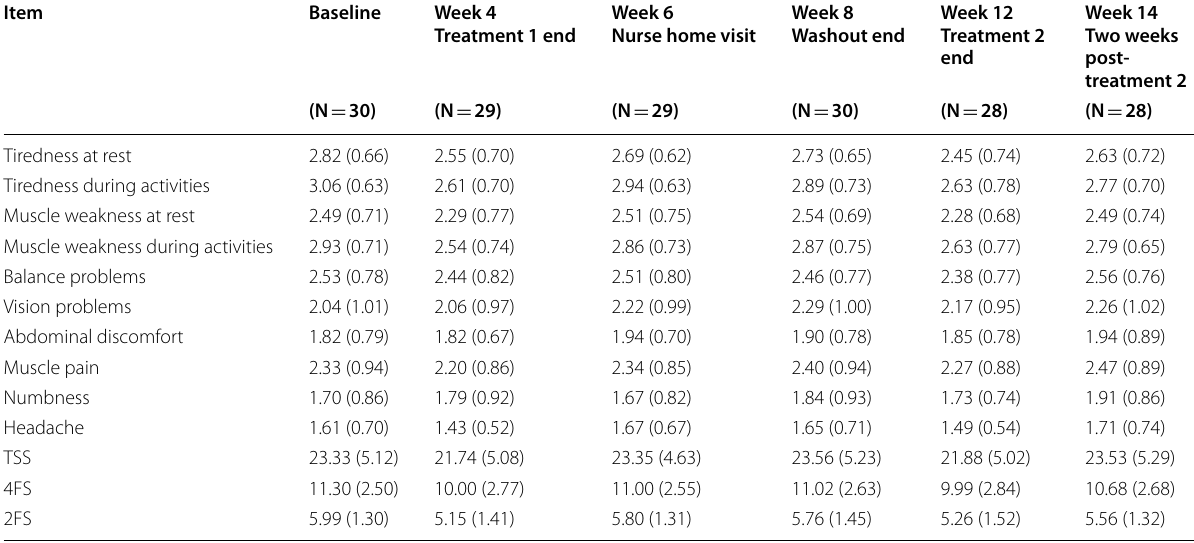
Table 2 PMMSA weekly scores (mean